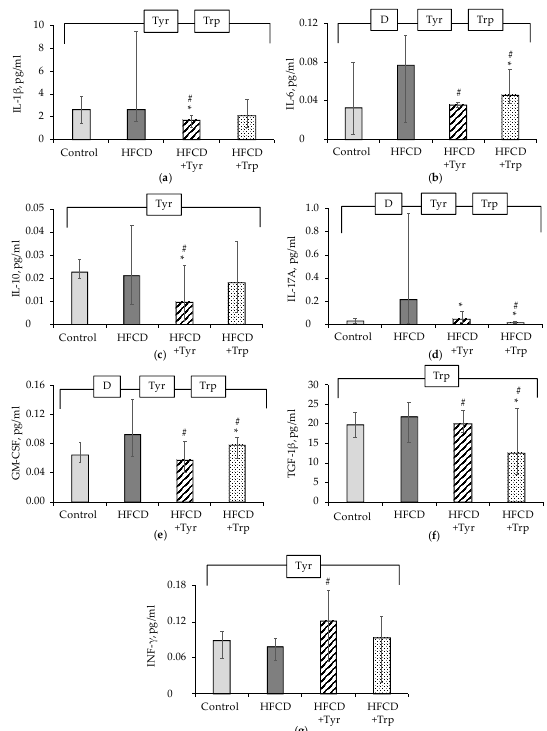
Figure 8. Levels of cytokines and adipokines in the rats’ spleen, median ± intervals of change: IL-1 β ( а ) IL-6 ( b ) IL-10 ( c ) IL-17A ( d ) GM-CSF ( e ) TGF-1 β ( f ) INF- γ ( g ). * the difference with the control group is significant; # the difference with the group receiving HFCD is significant, p < 0.05, Mann-Whitney test. The bracket above the bars denotes significant dependence on the factors: “diet” (D), “tyrosine” (Tyr), “tryptophan” (Trp), p < 0.05, 3-way ANOVA. The numbers of animals in the groups were